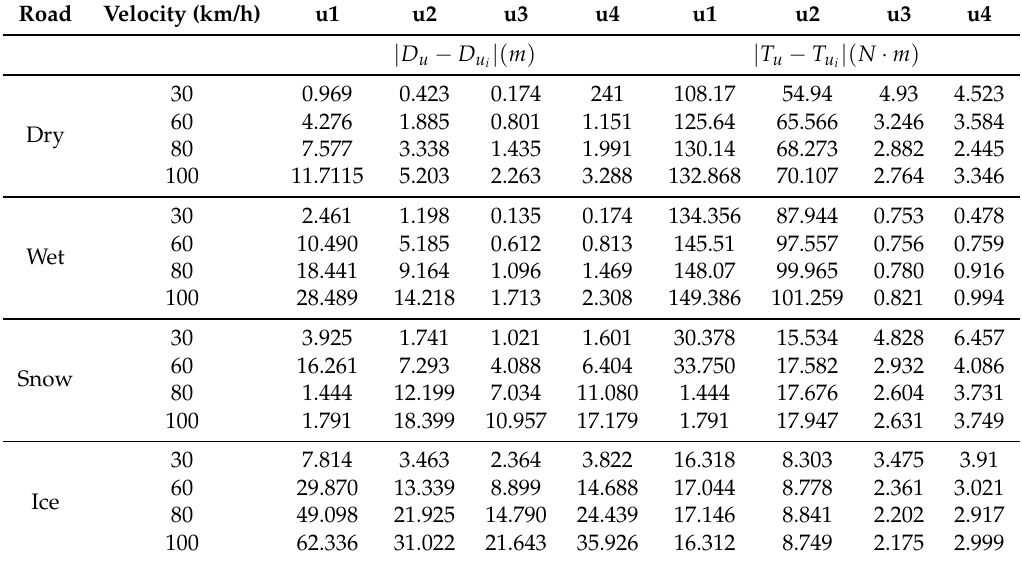
with d u , ( i = 1,2,3,4 ) . i bw